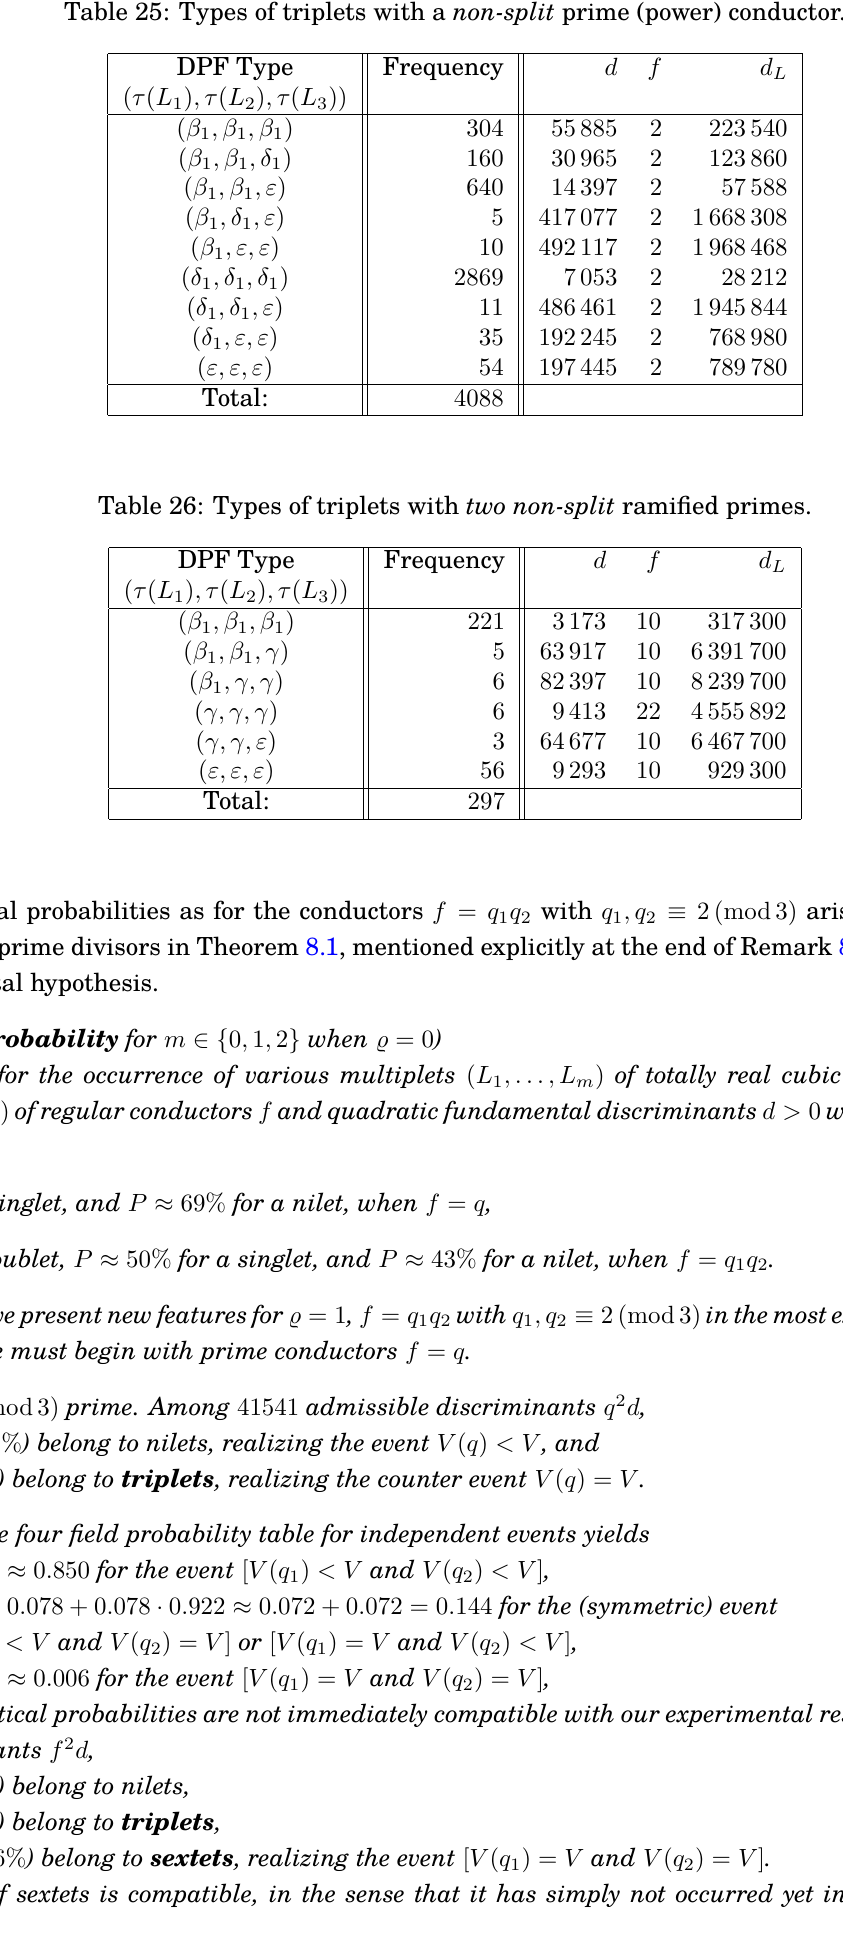
Table 25: Types of triplets with a non-split prime (power) conductor.